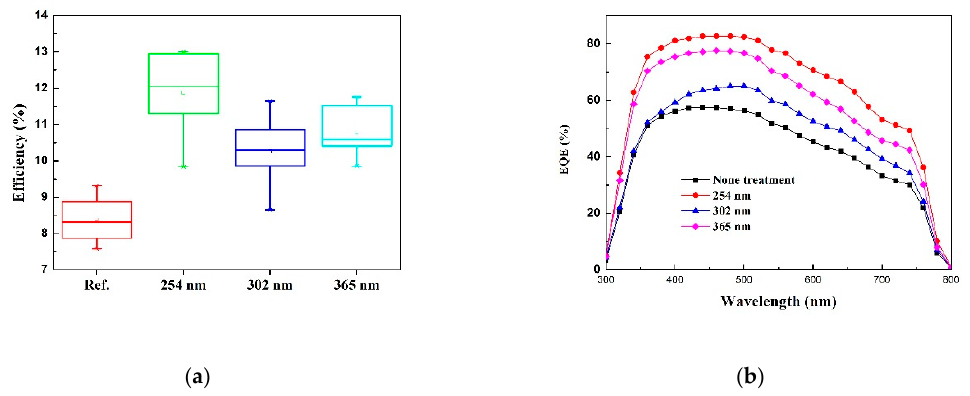
Figure 6. ( a ) E ffi ciency and ( b ) External quantum e ffi ciency (EQE) of perovskite solar cells (PSCs) treated by UV light sources (A, B, and